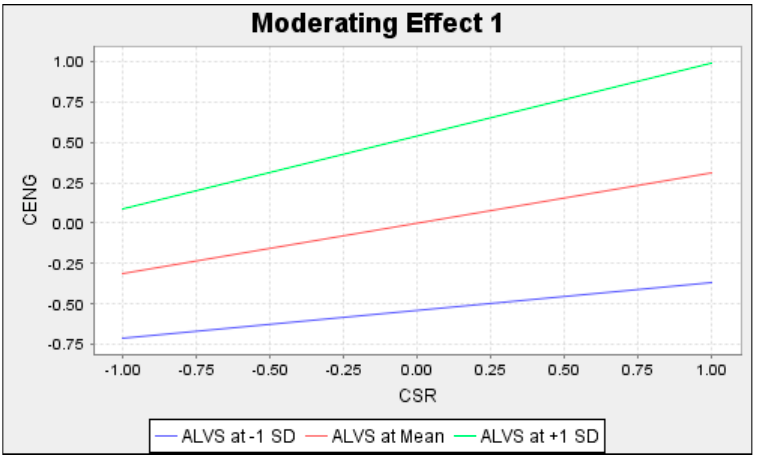
Figure 4. Simple slope analysis showing the moderating effect of ALVS in the relationship of CSR and CENG at three different levels of mean.